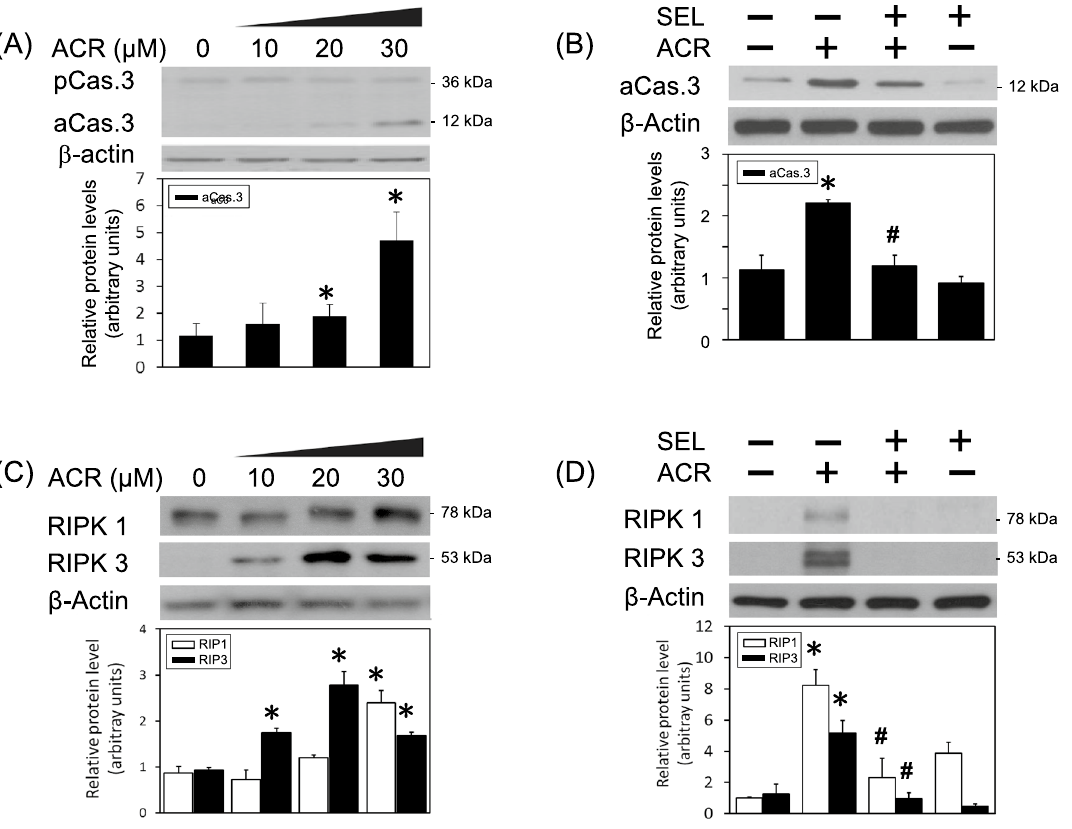
Figure 6. Effect of selumetinib on acrolein-induced programmed cell death. ( A ) Primary cultured cortical neurons were treated with acrolein (ACR, 0–30 μM) for 24 h. ( B ) Primary cultured cortical neurons were treated with acrolein (30 μM) with/without selumetinib (SEL, 10 μM) for 24 h. ( C ) Primary cultured cortical neurons were treated with acrolein (ACR, 0–30 μM) for 24 h. ( D ) Primary cultured cortical neurons were treated with acrolein (30 μM) with/without SEL (10 μM) for 24 h. Western blot assay was employed to measure active caspase 3 (aCas.3), RIP1 and RIP3. Each lane contained 30 μg protein for all experiments. Values are the mean ± SEM (n = 3/treatment). *p < 0.05 statistically significant in the acrolein groups compared with the control groups; # p < 0.05 statistically significant in acrolein plus SEL group compared with acrolein group by